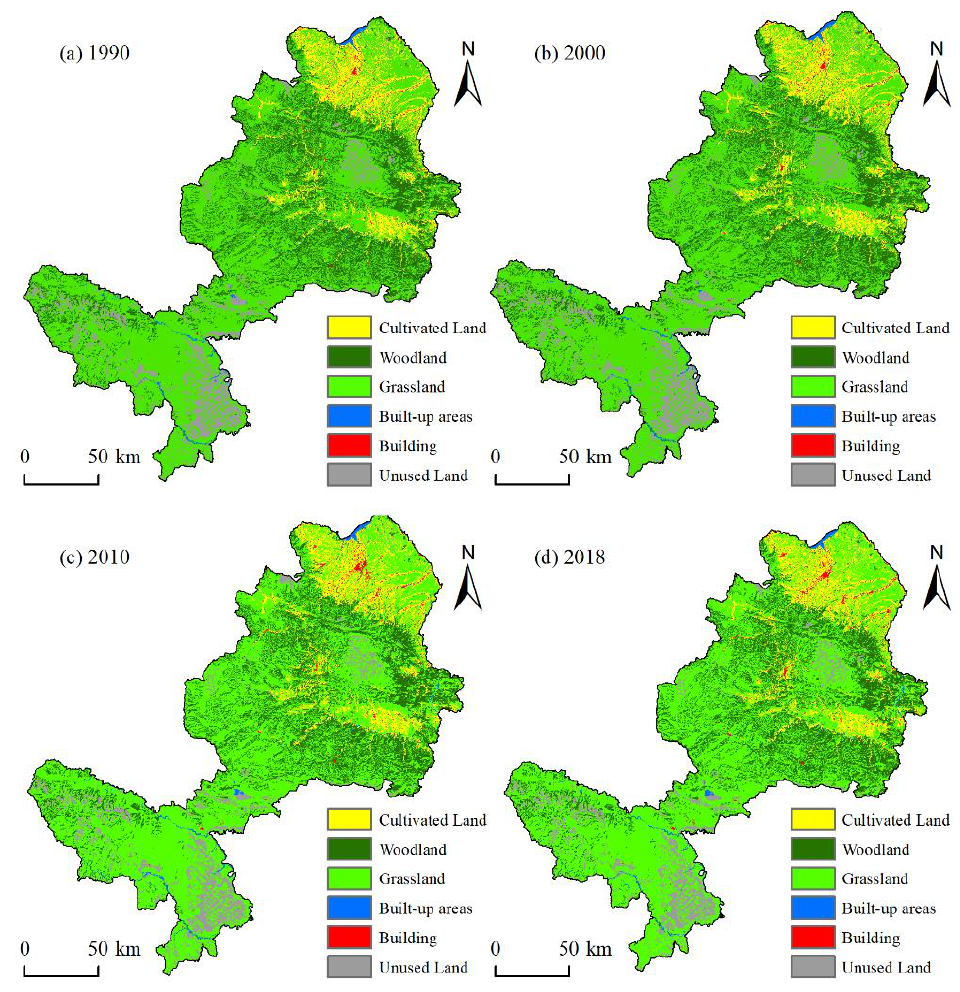
Figure 2. Land use of EFZUYR from 1990 to 2018. ( a ) 1990 ( b ) 2000, ( c ) 2010and ( d ) 2018.